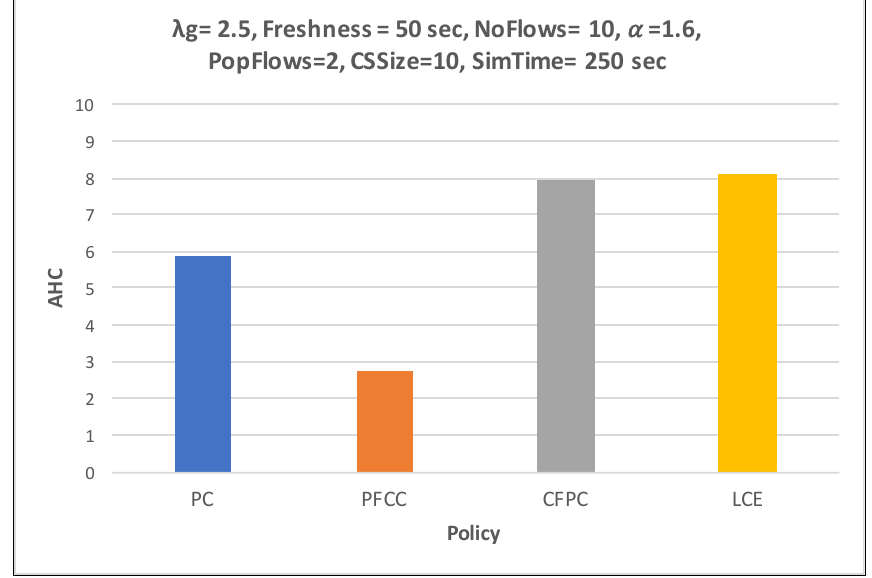
Figure 14. Average hop count for popular traffic.